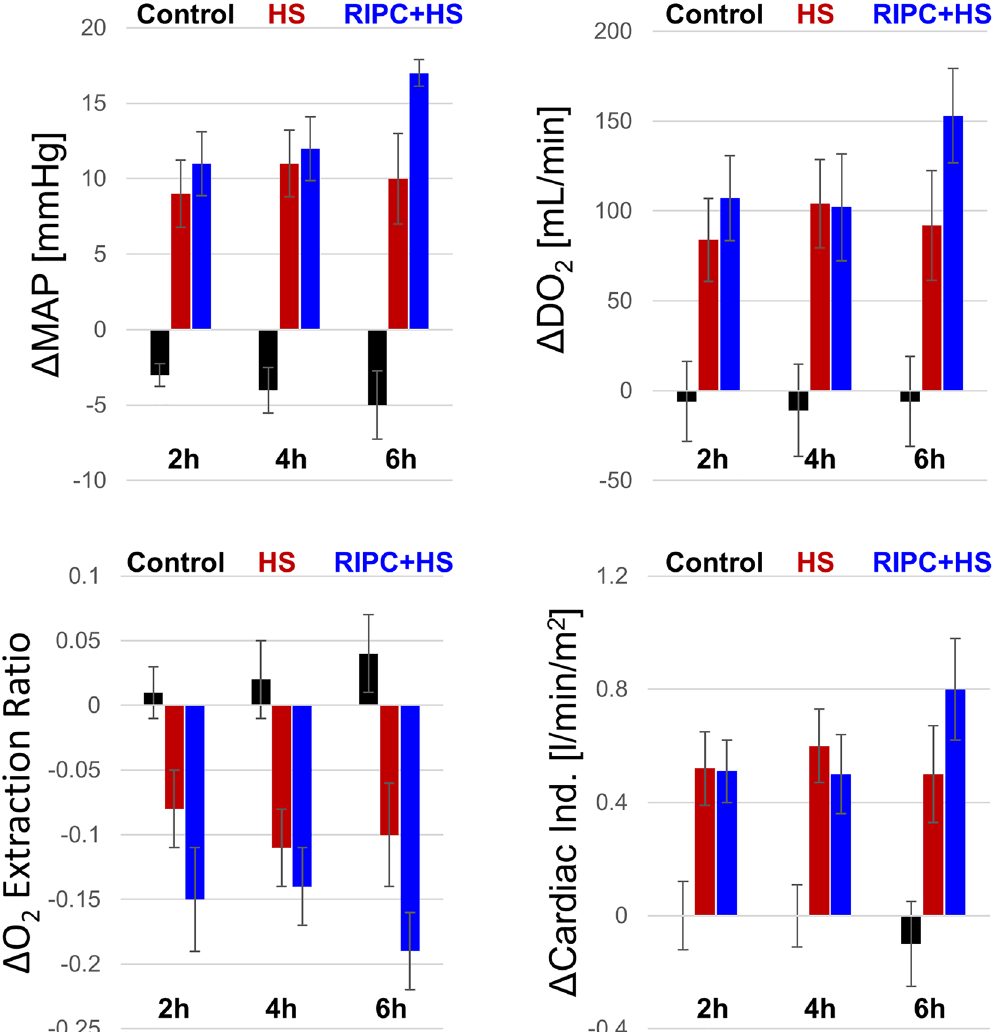
Figure 4. Lactate and Tissue Oxygenation. ( A ) Lactate: Measurements of individual animals for each group. Note the delayed rise in lactate in animals with RIPC prior to bleeding (RIPC + HS) versus those bled without RIPC (HS). ( B , C ) Tissue Oxygenation: Bars represent mean ± SD. Note significant increase in global oxygen delivery (DO 2 ) and decrease in tissue oxygen extraction ratio (ER) in follow-up period compared to the end of bleeding in animals of RIPC + HS group but not in animals of HS group. ‡ p < 0.05 by paired t-test with Bonferroni’s correction for multiple comparisons. #animals: Controls n = 7; HS n = 13; RIPC + HS n =